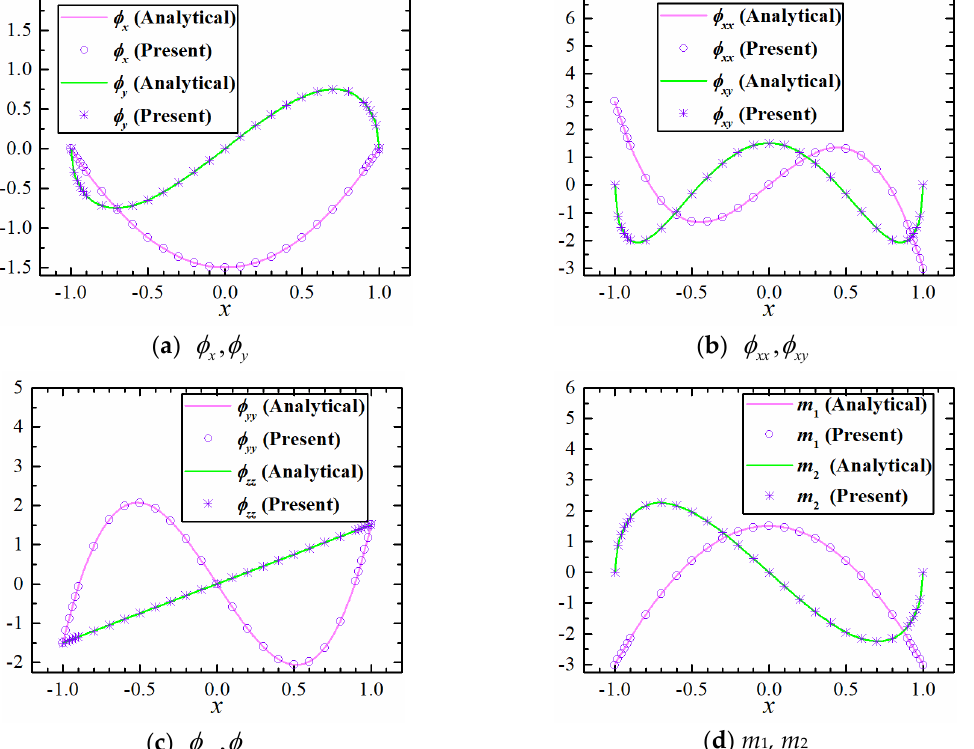
Figure 5. Derivatives of the velocity potential and m j terms on the sphere surface along equator